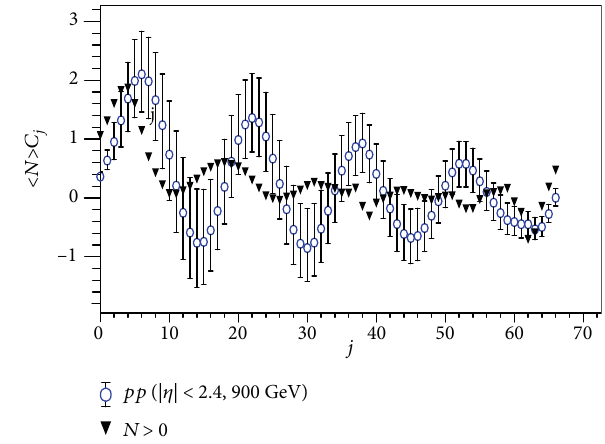
Figure 11: Illustration of oscillatory behaviour of the coe ffi cients C removing the probability P ð 0 Þ and starting with P ð 1 Þ .